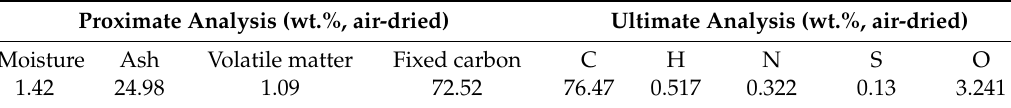
Table 2. Proximate and ultimate analyses of bituminous coal char.